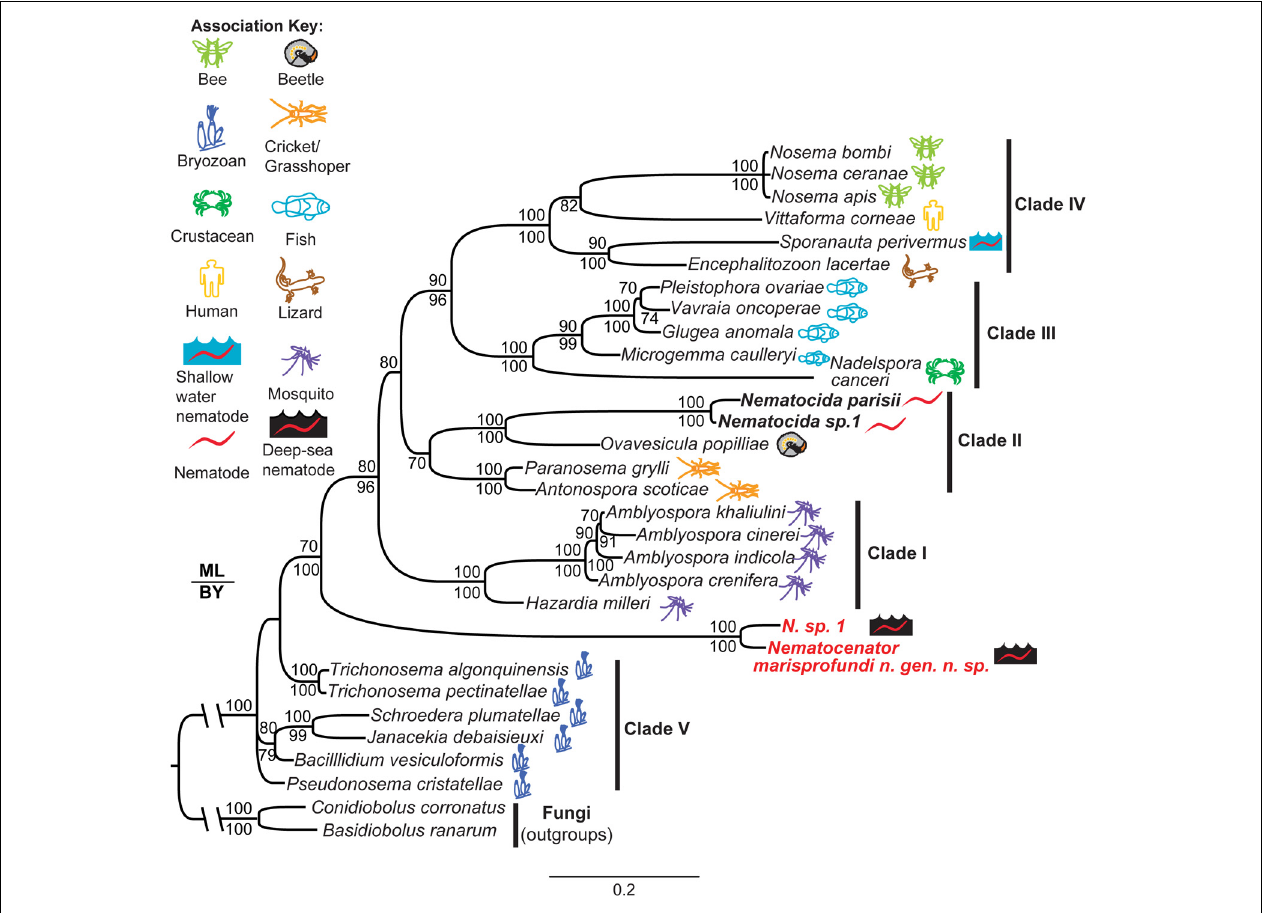
FIGURE 6 | Phylogenetic analysis of N. marisprofundi . A combined maximum likelihood and Bayesian analysis of the small ribosomal DNA from selected microsporidia and close relatives. Two zygomycete fungal taxa were used as outgroups (see Methods). The five major microsporidian clades are noted with Roman numerals (after Vossbrinck